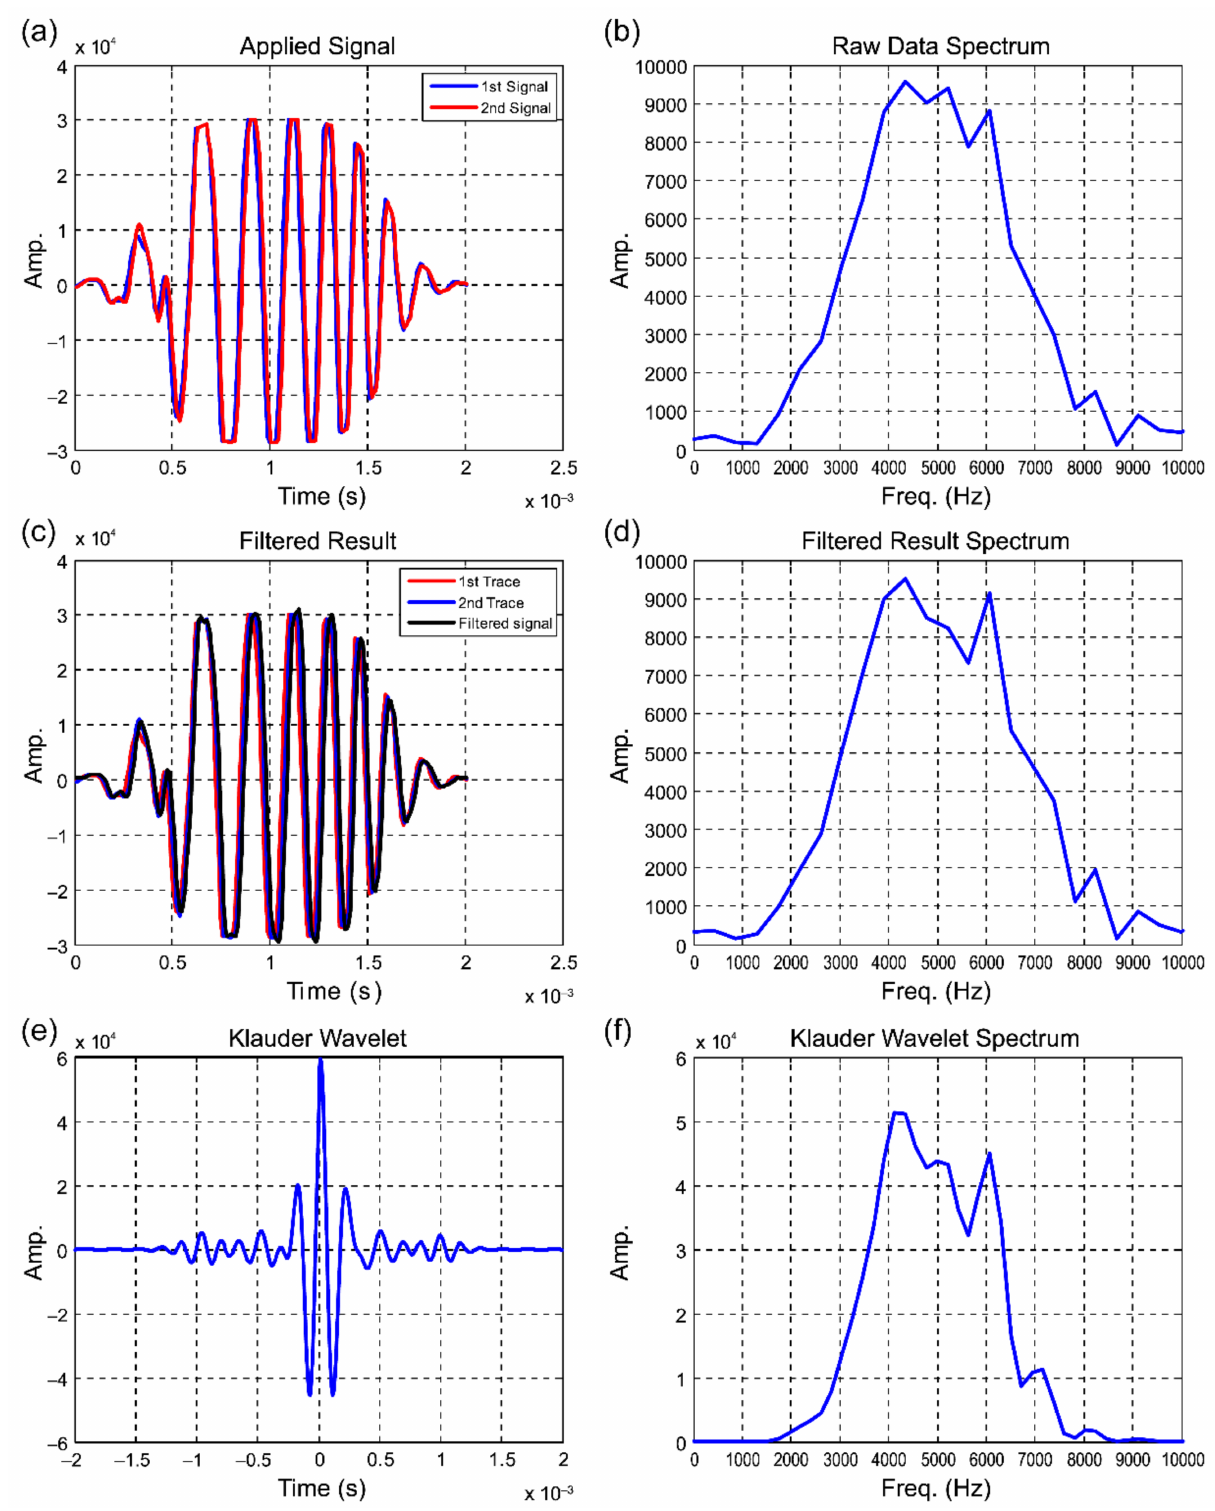
Figure 9. Based on the second signal, the filtered signal was obtained through combination with the first signal. ( a ) Superposition of two traces extracted from the first reflection signal of raw data. ( b ) Amplitude spectrum of ( a ). ( c ) Adaptive filtered source signal obtained from ( a ). ( d ) Amplitude spectrum of ( c ). ( e ) Klauder wavelet obtained through the correlation of the first reflection signal extracted from raw data and adaptive filtered source signal. ( f ) Amplitude spectrum of ( e